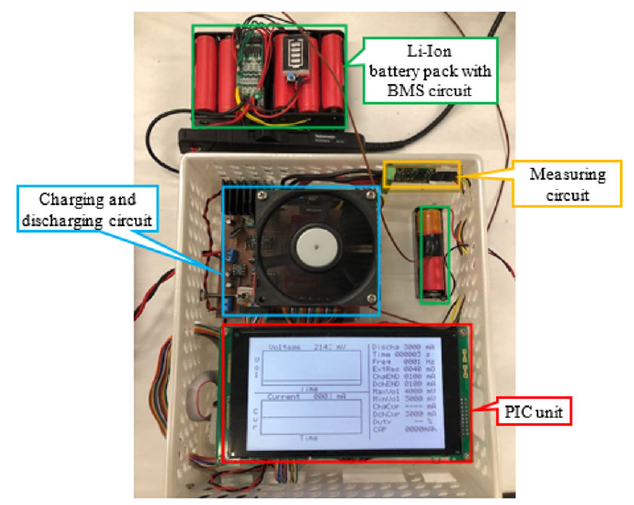
Figure 2. System appearance (during operation for battery pack 3S4P or for single cell